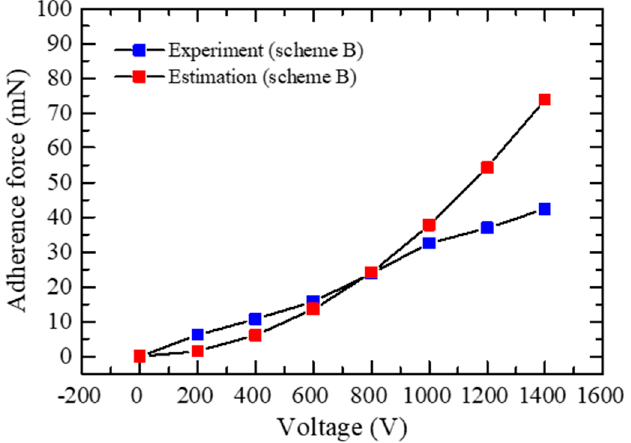
Figure 7. Adhesive force by experiment versus adhesive force by estimation.